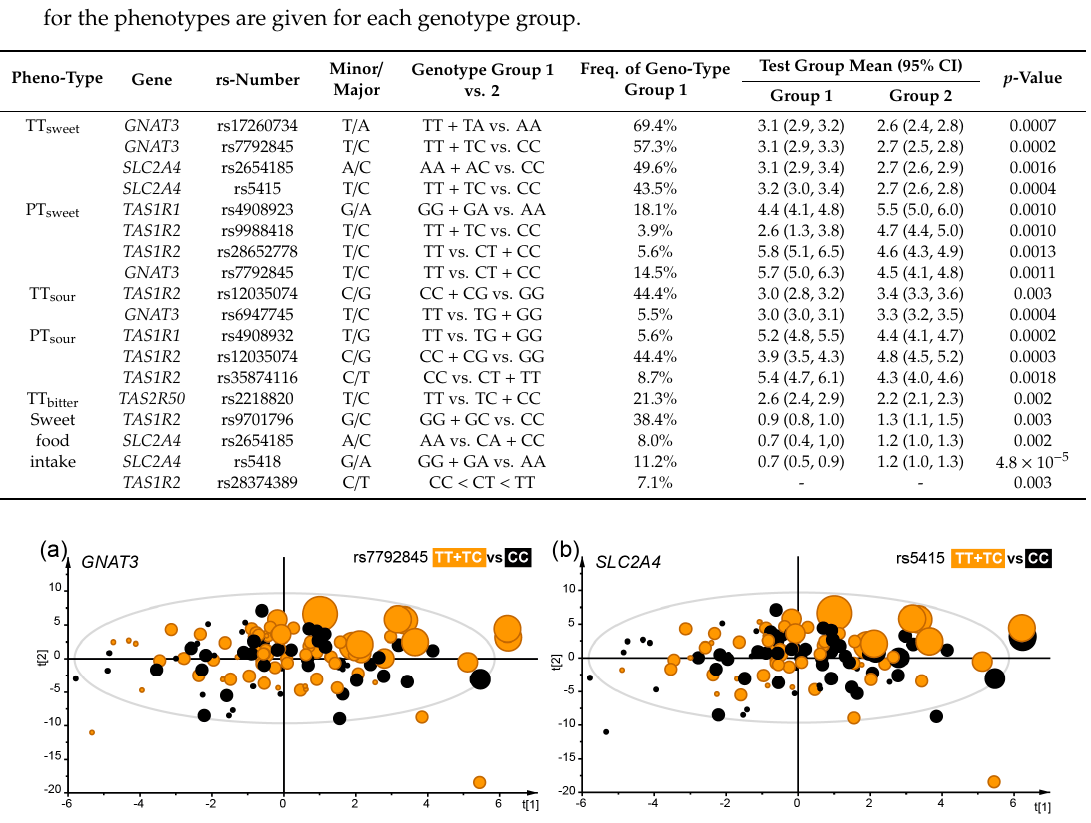
presented in Tables S3–S5. Variants with minor allele count < 5 were excluded. Mean (95% CI) values